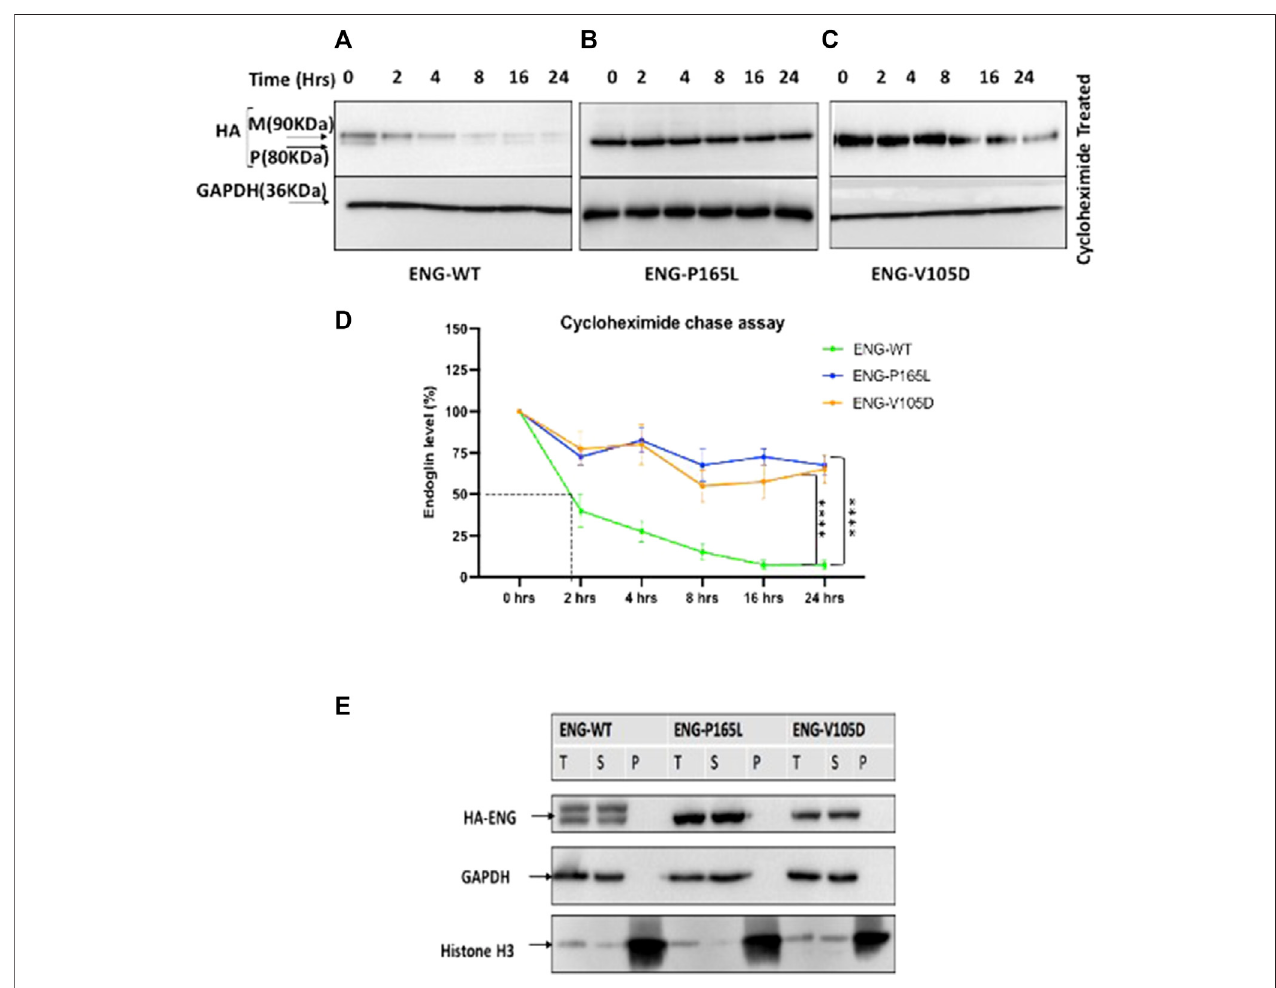
FIGURE 4 | Cycloheximide (CHX) chase assay for stably transfected HEK293 Endoglin WT and the two mutant variants P165L and V105D. (A – C) HEK293 stably transfectedwithp.ENG-WT,p.P165L,andp.V105DweretreatedwithCycloheximide(100 μ g/ml)forthetimepoints0,2,4,8,16,and24 h. (D) LinegraphforEndoglin Cycloheximide chase assay represents mean densities of WT Endoglin and mutants relative to untreated at 0 h, normalized with loading control (GAPDH). (E) Western blot analysis of Endoglin WT and mutant variants ’ aggregation state. Harvested cells were lysed in 1%Triton lysis buffer (TBSt) followed by centrifugation at 20,000 gat4 ° C.Supernatant(S),Pellet(P),andTotalLysate(T)wereresolvedinSDSpageandthenimmunoblottedagainstHA-ENG.HistoneH3wasusedasamarker for P fraction and GAPDH for the T and S fractions. Error bars represent SEM from 4 independent experiments ( n = 4). Statistical signi fi cance between two groups was assessed using repeated measures two-way ANOVA; (*) p ≤ 0.05; (**) p ≤ 0.01; (***) p ≤